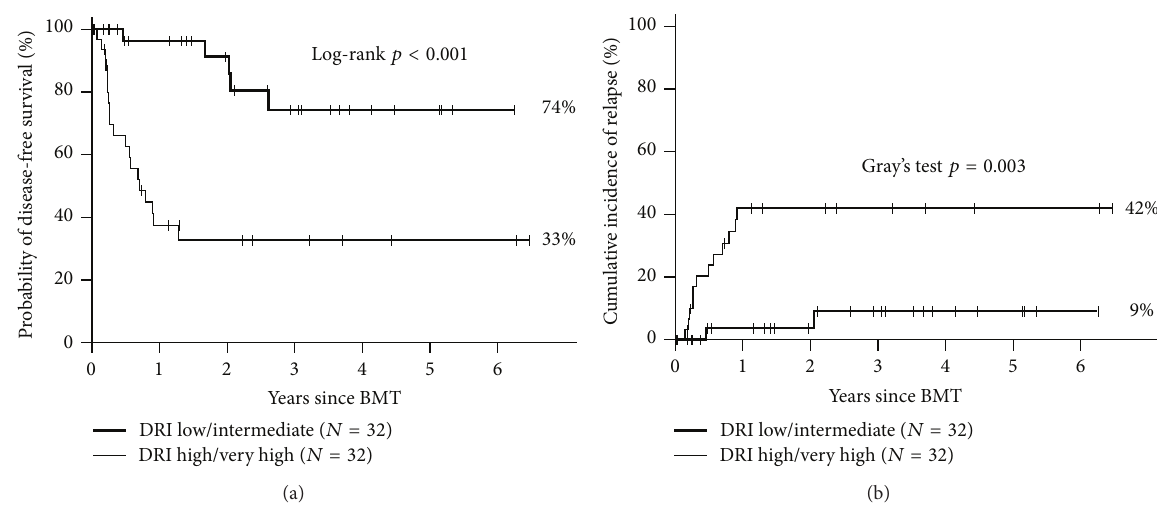
Figure 2: Effect of disease risk index on (a) disease-free survival and (b) relapse following MA haplo-HSCT.